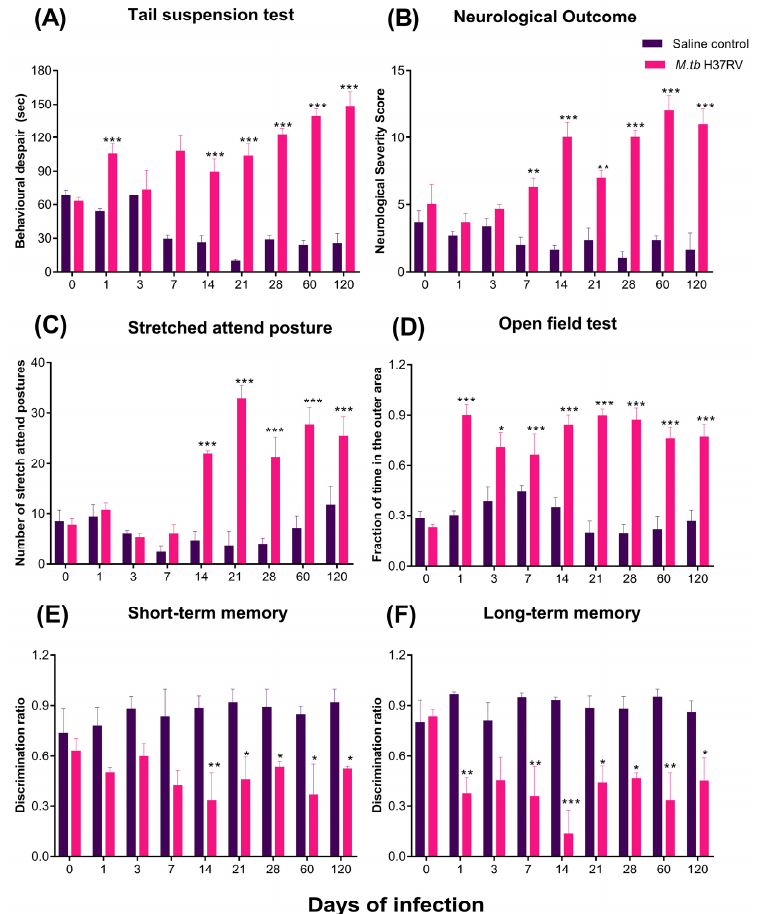
Figure 14. Behaviour abnormalities showed by pulmonary TB mice. ( A ) Tail suspension test (depression-like behaviour), ( B ) neurological outcome, ( C ) stretched attend posture (anxiety-like behaviour), ( D ) open field test (unconditioned fear and anxiety), ( E ) short-term and ( F ) long-term memory. Animals infected with M. tb in the lungs present behavioural abnormalities such as depression-like behaviour, anxiety-like behaviour, neurological damage, and short- and long-term memory damage. Data are expressed as mean ± SEM. Tail suspension test F (1, 4) = 225.2, p = 0.0001, two-way ANOVA; *** p < 0.0001, Sidak’s multiple comparisons test ( α = 0.05) ( n = 6). Neurological outcome F (1, 4) = 186.3, p = 0.0002, two-way ANOVA; ** p < 0.001, *** p < 0.0001, Sidak’s multiple comparisons test ( α = 0.05) ( n = 6). Stretched attend posture F (1, 4) = 166, p = 0.0002, two-way ANOVA; *** p < 0.0001, Sidak’s multiple comparisons test ( α = 0.05) ( n = 6). Open field test F (1, 6) = 326.5, p < 0.0001, two-way ANOVA; * p < 0.01, *** p < 0.0001, Sidak’s multiple comparisons test ( α = 0.05) ( n = 6). Short-term memory F (1, 4) = 49.05, p = 0.0022, two-way ANOVA; * p < 0.01, ** p < 0.001, Sidak’s multiple comparisons test ( α = 0.05) ( n = 6). Long-term memory F (1, 4) = 116, p = 0.0004, two-way ANOVA; * p < 0.01, ** p < 0.001, *** p < 0.0001, Sidak’s multiple comparisons test ( α = 0.05) ( n =